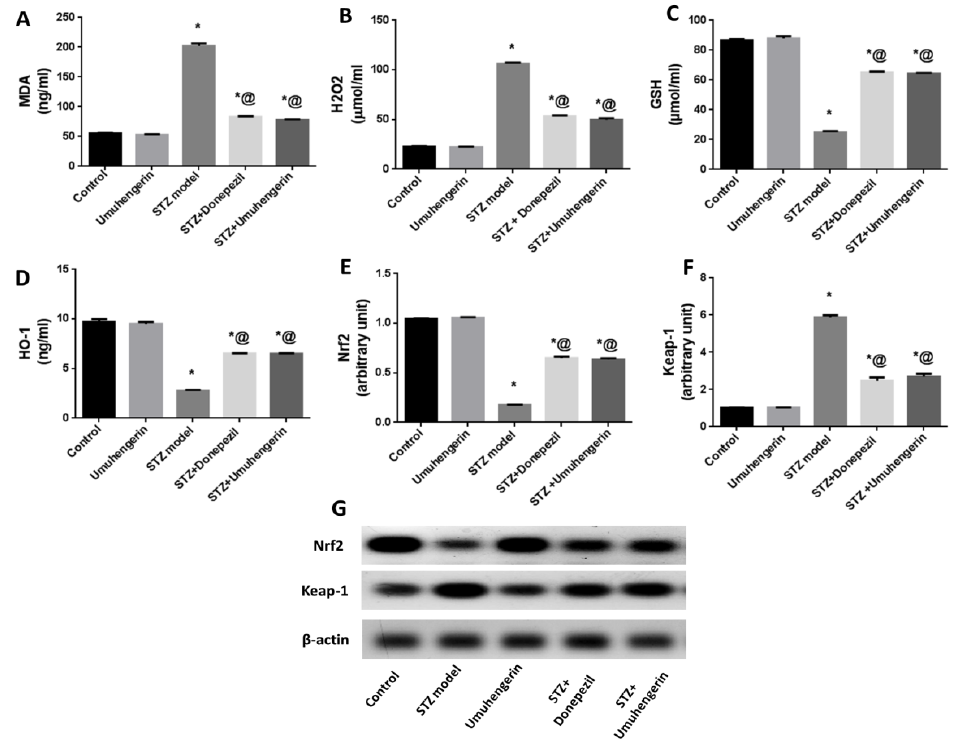
Figure 3. Effect of umuhengerin on oxidative stress associated with STZ administration. ( A ) MDA, ( B ) H 2 O 2 , ( C ) GSH, and ( D ) HO-1 brain contents were estimated, in addition to ( E ) Nrf2 and ( F ) Keap-1 protein expression. ( G ) Western blot of Nrf2 and Keap-1. Values are expressed as mean ± SEM; n = 7. * p < 0.05 vs. control group, @ p < 0.05 vs. ICV-STZ group .